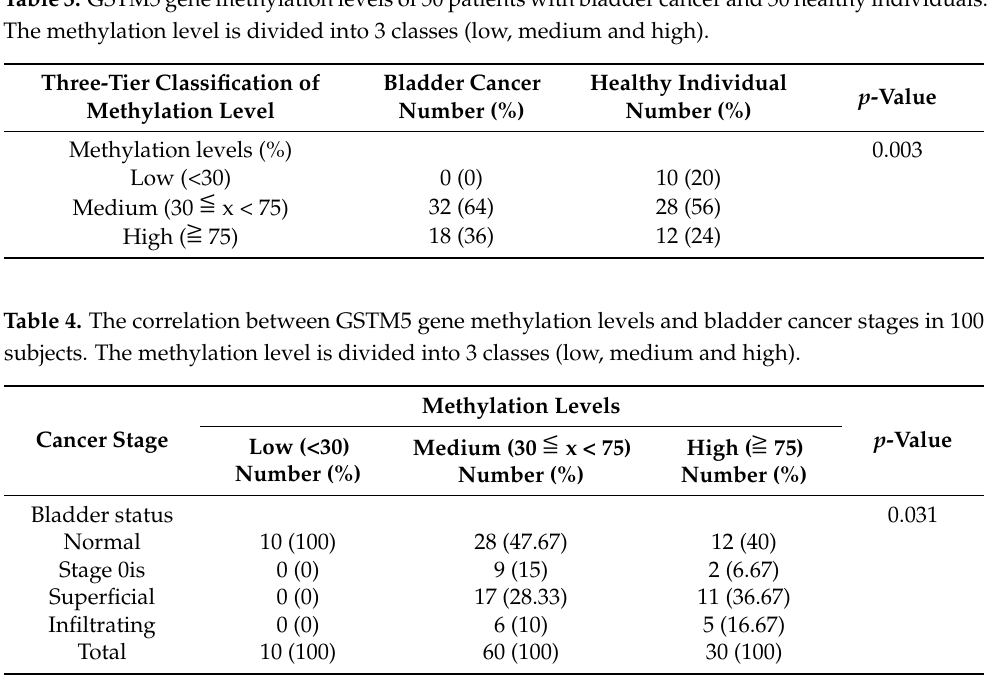
Table 4. The correlation between GSTM5 gene methylation levels and bladder cancer stages in 100 subjects. The methylation level is divided into 3 classes (low, medium and high).